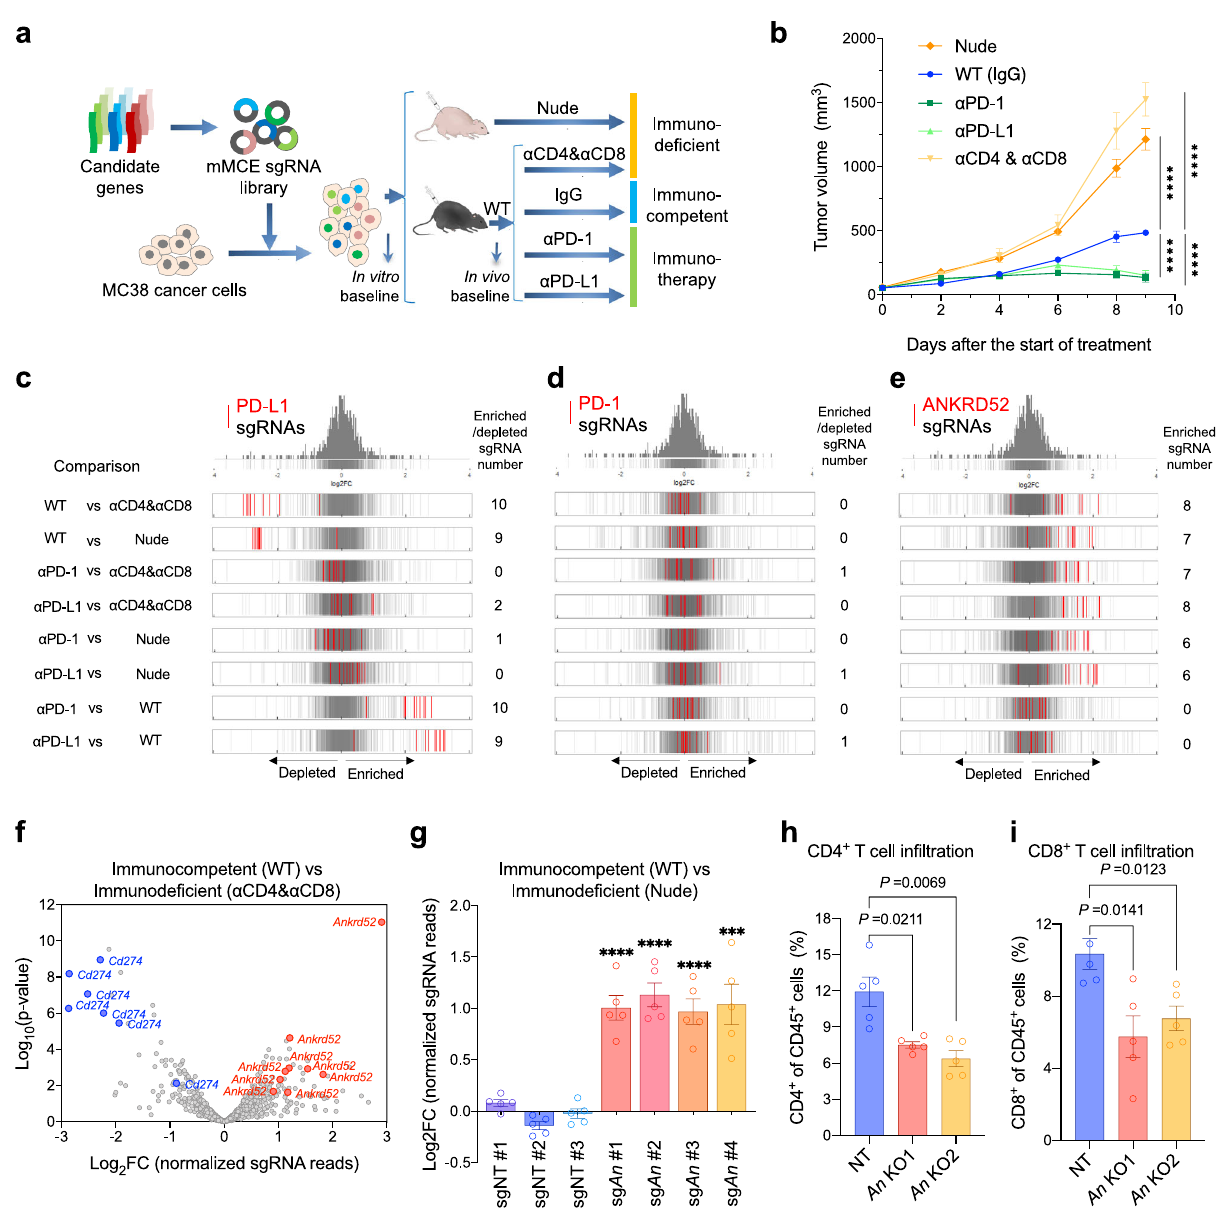
Fig. 2 In vivo CRISPR screen targeting pro fi led mutations identi fi es ANKRD52 as a key modulator of cancer immunity. a Schematic overview of in vivo CRISPR screen to validate candidates from immune-selected mutations. b Tumor growth curves of MC38 tumors in nude mice ( n = 8), and WT mice treated with rat IgG2a and IgG2b isotype ( n = 8), PD-1 antibody ( n = 10), PD-L1 antibody ( n = 10), or CD4 and CD8 antibodies ( n = 7). Data are represented as mean ± s.e.m., **** P < 0.0001, signi fi cance was determined using two-way analysis of variance (ANOVA). c – e Distribution histograms of log 2 Fold-change (FC) for all 10 sgRNAs targeting Cd274 ( c ), Pdcd1 ( d ) or Ankrd52 ( e ) as indicated in red lines, overlaid on gray gradient depicting the overall distribution (Cut-off: |FC | > 1.5, P < 0.05 for enrichment or depletion, analyzed by edgeR). f , Volcano plot for selected top guides for Cd274 and Ankrd52 (Cut-off: |FC | > 1.5, P < 0.05, analyzed by MAGeCK). g In vivo competition assay with equal number mixture of MC38 cells infected with sgRNA for non-targeting control (NT) or Ankrd52 ( An ) in WT mice ( n = 5) and nude mice ( n = 5). Data are represented as mean ± s.e.m., *** P = 0.0004, **** P < 0.0001, signi fi cance was determined using two-tailed unpaired Student ’ s t -test to compare sg Ankrd52 vs sgNT #2. h , i , Flow cytometry analysis of CD4 + ( h ) and CD8 + ( i ) T cell populations from NT and Ankrd52 knockout ( An KO) tumors ( n = 5 per group). Data are representative of two independent experiments and represented as mean ± s.e.m., signi fi cance was determined using two-tailed unpaired Student ’ s t -test. See also Supplementary Fig. 2 – 5. Source data are provided as a source data fi